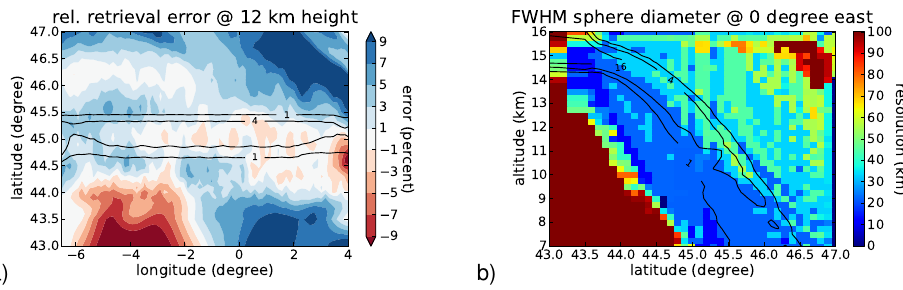
Fig. 8. The relative retrieval error and resolution for a linear flight track employing four channels instead Fig. 10. The relative error of the retrieval and resolution for a linear flight track employing four channels instead of only one. Panel (a) of only one. Panel (a) shows the relative retrieval error (cf. Fig. 4b). The FWHM sphere diameter is shows the relative error of the retrieval (cf. Fig. 5b). The FWHM sphere diameter is shown in (b) (cf. Fig. 8a). The number of tangent points shown in panel (b) (cf. Fig. 6a). The number of tangent points within the depicted volume elements is within the depicted volume elements is overlaid as a contour overlaid as a contour plot.